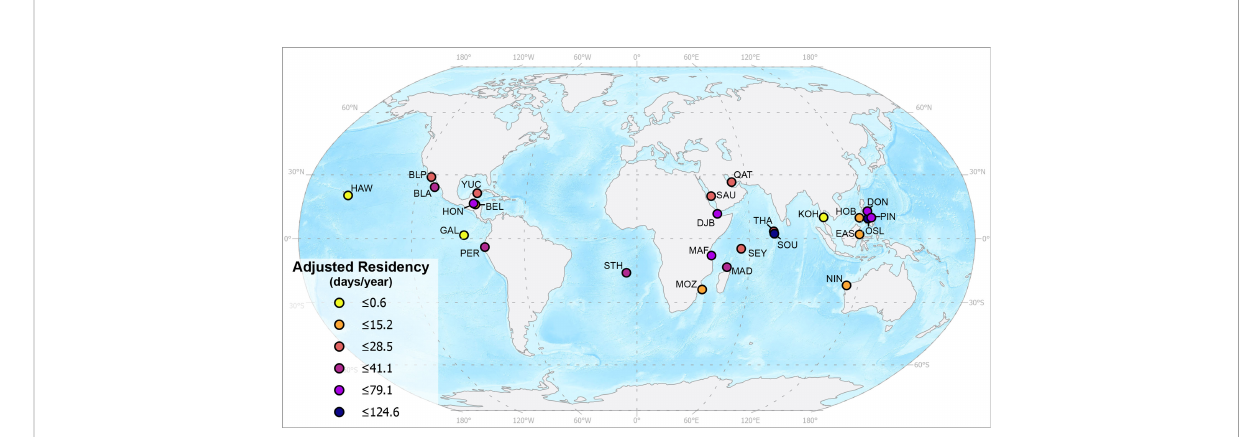
FIGURE 4 Global map with all 25 whale sharks study sites with their adjusted residency values in days per year. Map produced using ESRI ArcGIS Pro using the 1:50 m Ocean Bottom and the 1:110 m Land datasets from Natural